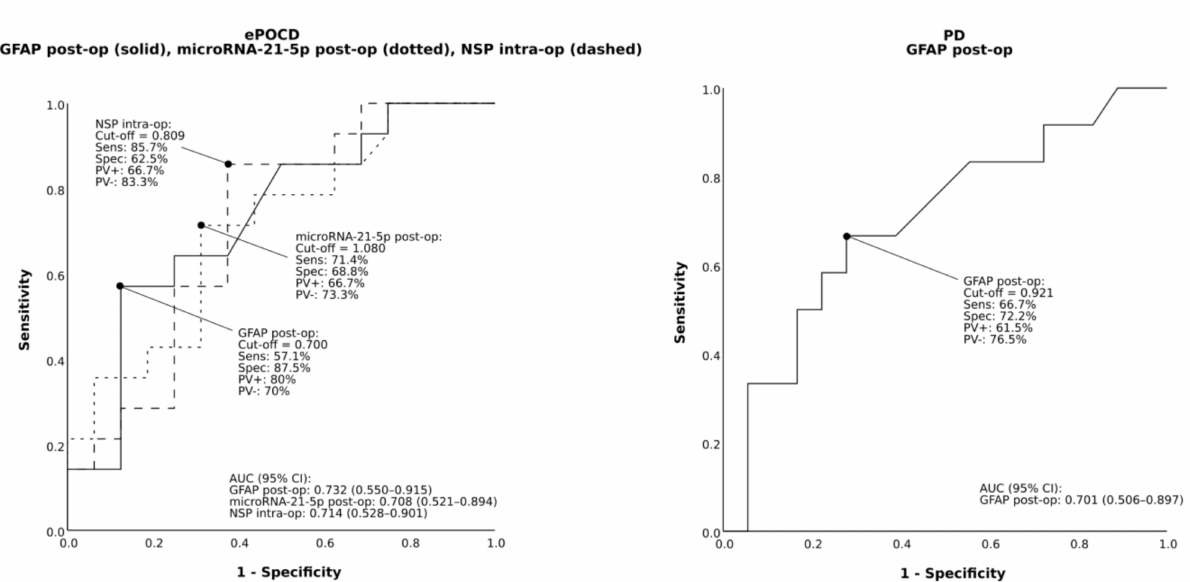
Figure 2. Receiver operating characteristic of postoperative expression (i.e., 24 h postoperative to end of surgery plasma level ratio [post-op]) of microRNA-21-5p and glial fibrillary acidic protein (GFAP), as well as intraoperative expression (i.e., end to start of surgery plasma level ratio [intra-op]) of neuroserpin (NSP) to predict postoperative delirium (PD) and early postoperative cognitive dysfunction (ePOCD). AUC indicates area under the curve; CI, confidence interval; PV+, positive predictive value; PV-, negative predictive value; Sens, sensitivity; Spec,